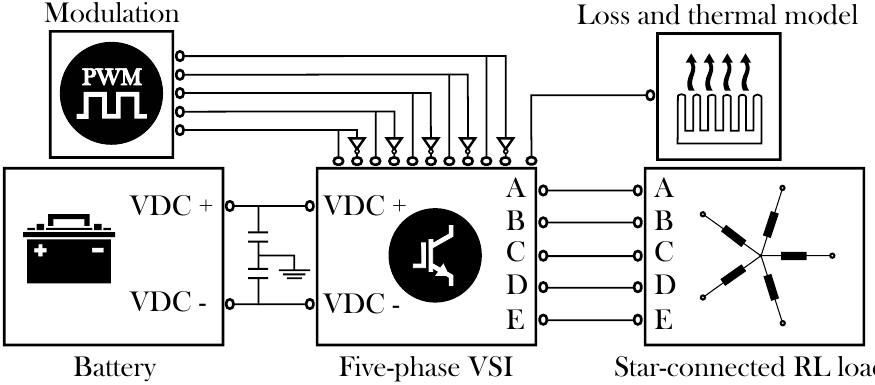
Figure 8. Block diagram of the constituting parts of the open-loop Simulink model. Table 5. Most relevant parameters of the simulated International Rectifier AUIRGPS4067D1